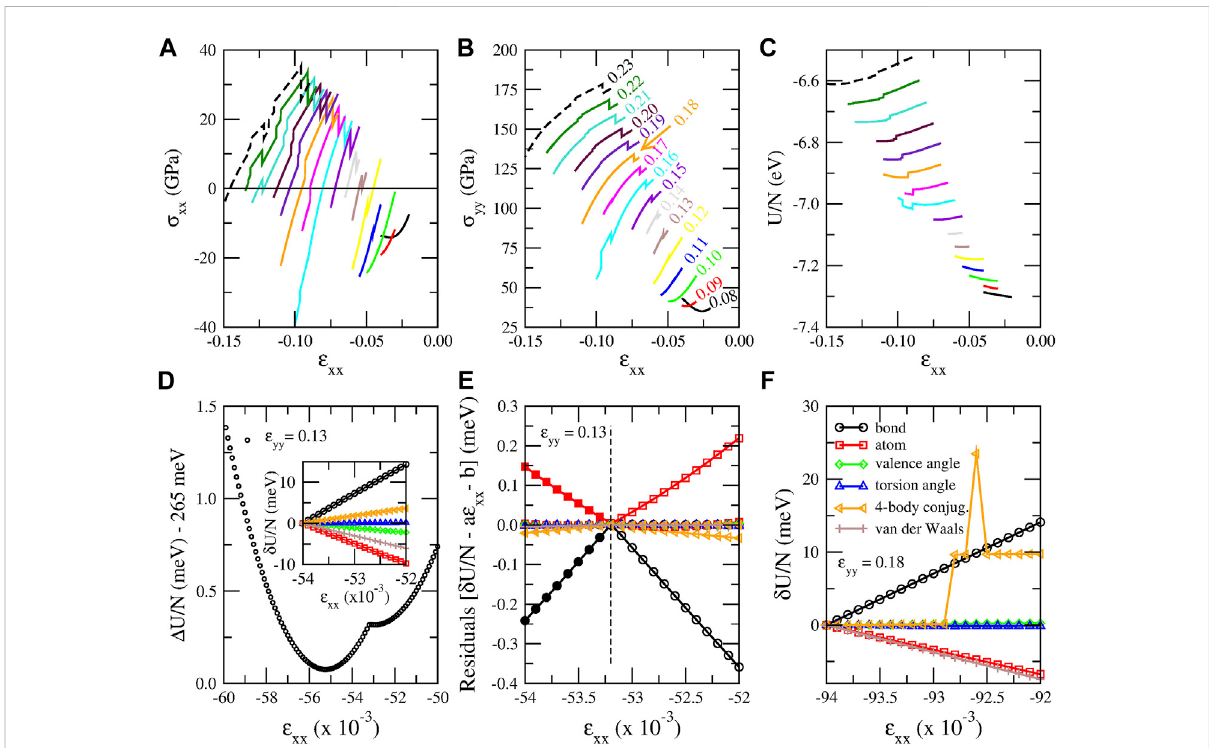
FIGURE 6 (A) – (C) “ Jumps ” (discontinuities) in stress and energy plots obtained using the CHON-2019 potential. (A) Stress along x direction ( σ xx ), (B) stress along y direction( σ yy )and (C) energyperatom( U / N )asafunctionofstrainalong x direction( ε xx )for fi xed ε yy valuesindicatedwithdifferentcolors.The ε yy value corresponding to each curve of panels (A) , (B) and (C) is shown next to each curve in panel (B) with the same color. (D) Strain energy per atom Δ U / N = U / N − U coh shiftedby265 meVversus ε xx for ε yy =0.13,showingthediscontinuouschangeintheenergyslope.Intheinset:energy per atom for the six terms constituting the energy of the system. Each energy term is shifted by the value it has for ε xx = − 0.0540. (E) Residuals between the energy per atom values of each energy term shown in the inset of panel (D) and their fi tted linear functions for − 0.0540 ≤ ε xx ≤ − 0.0532 (open symbols) and for − 0.0532 ≤ ε xx ≤ − 0.0520 (solid symbols). The residuals are calculated for all the energy values in the [-0.0540, -0.0520] interval and not only for the values used for the fi tting. (F) The six energy terms for ε yy = 0.18 and − 0.0940 ≤ ε xx ≤ − 0.0920. The legends of panel (F) apply both in panel (E) and the inset of panel (D) . The ε xx increment in all these plots is 10 – 4